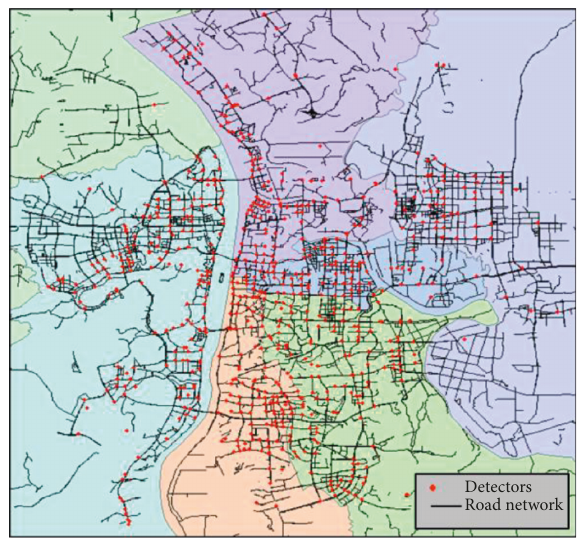
Figure 1: Road network and distribution of LPR system in the Changsha